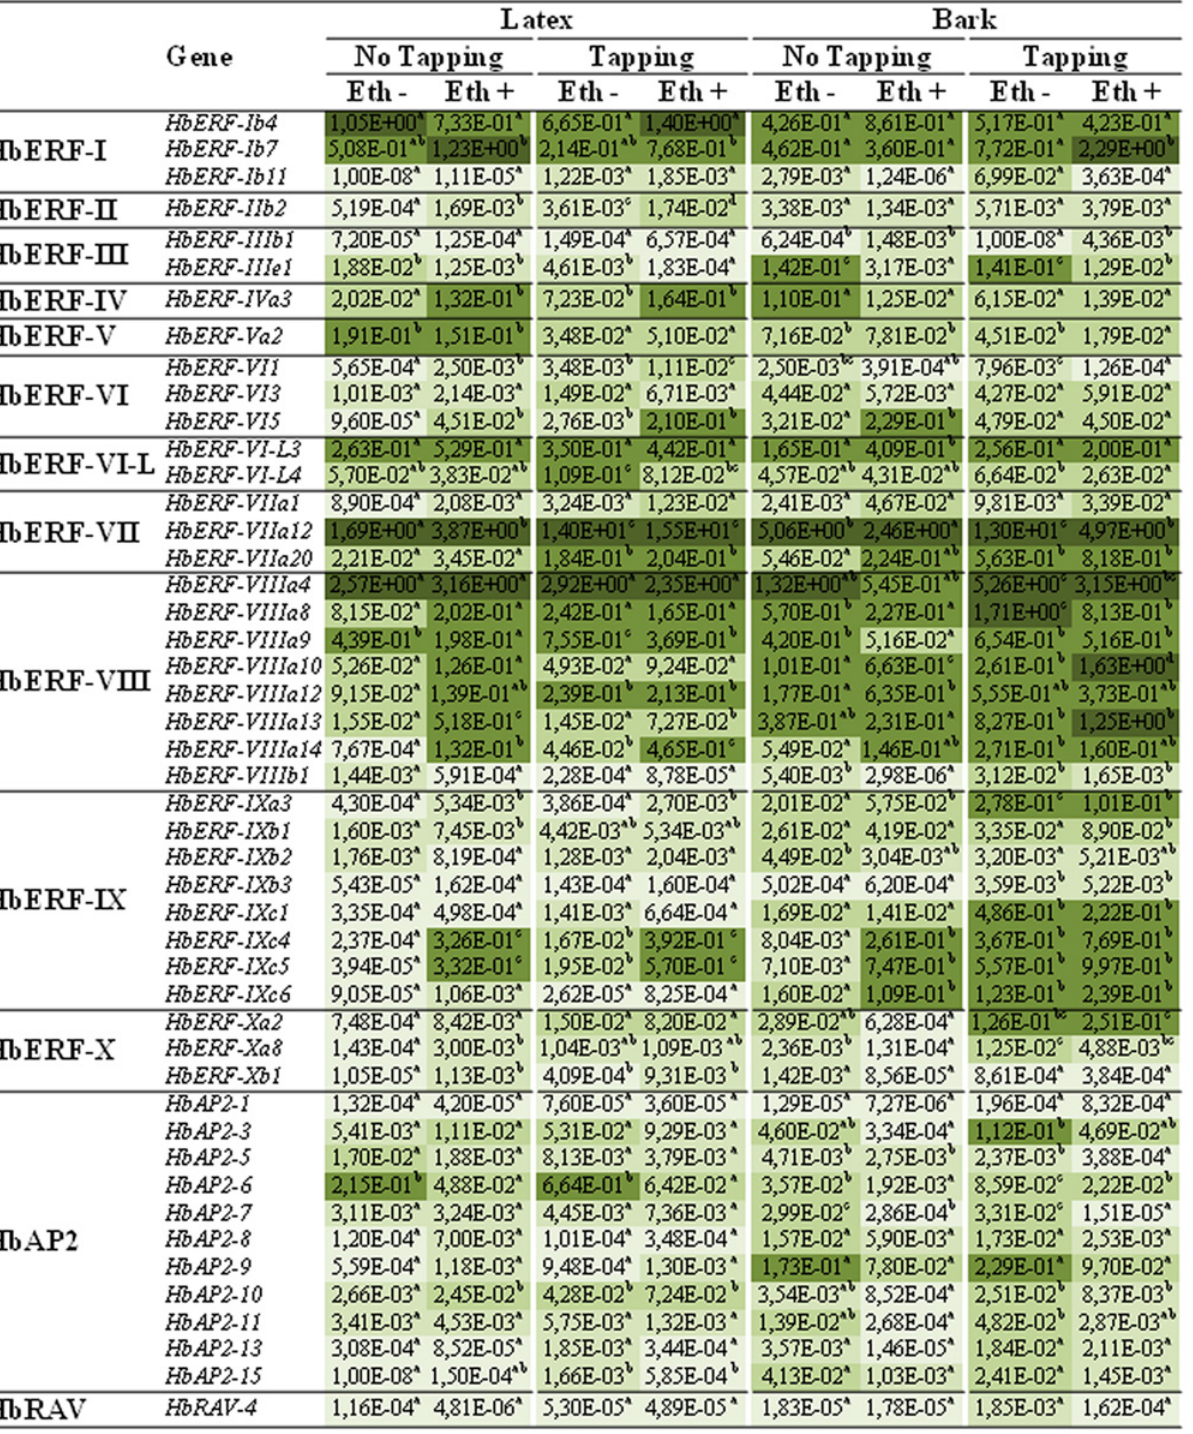
PLOS ONE | DOI:10.1371/journal.pone.0123618 April 23,